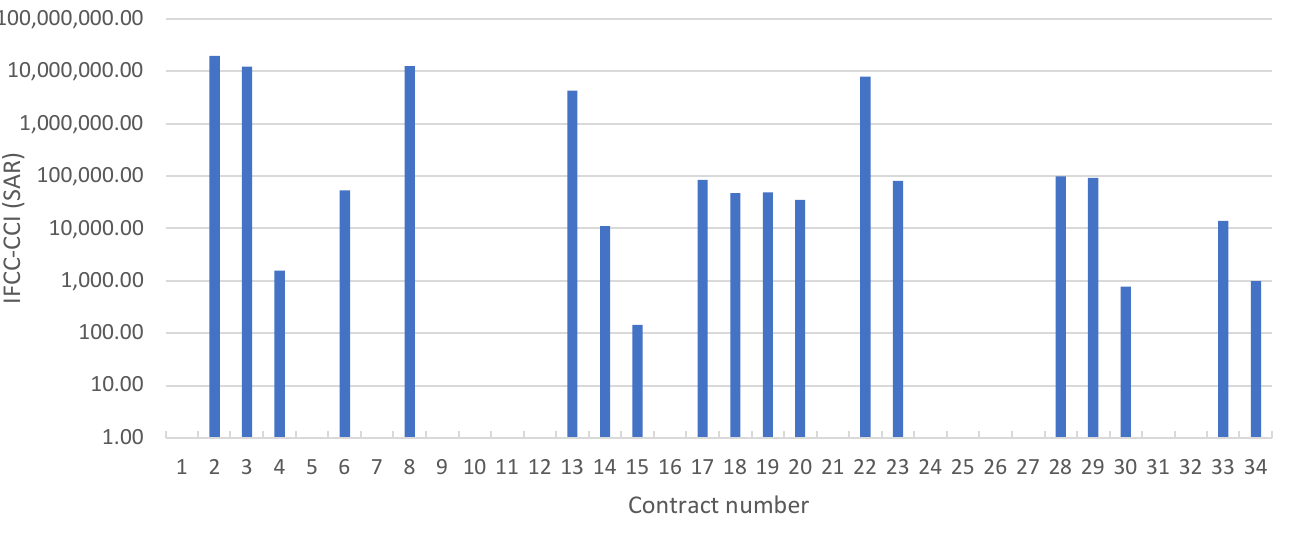
Figure 5. Absolute difference between final contract cost ( FCC ) and contract cost ( CC ) of 34 projects.